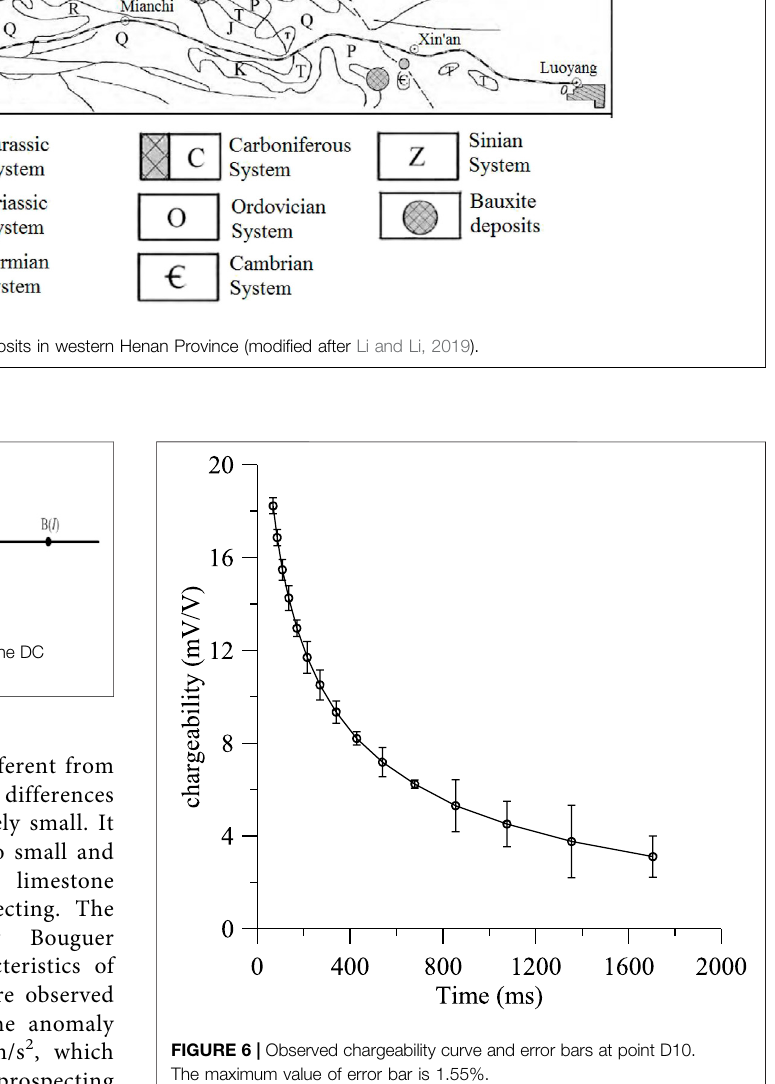
Frontiers in Earth Science |